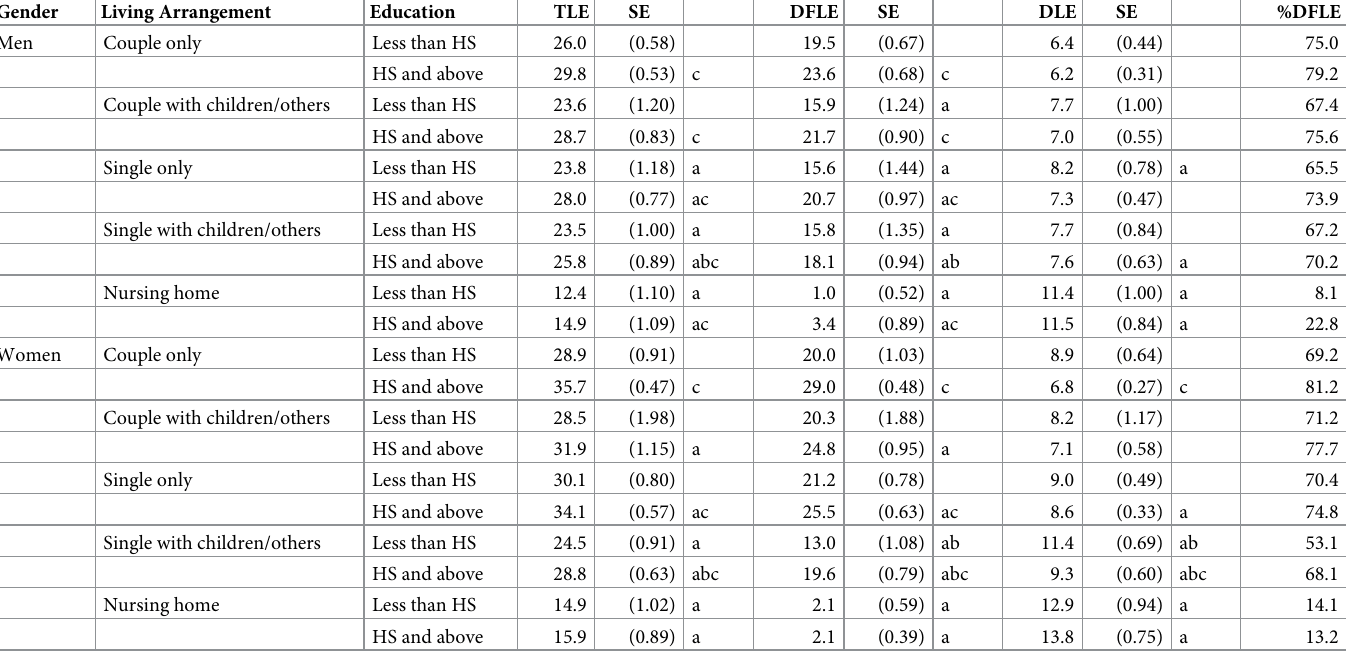
Table 12. Total, disability-free, and disabled life expectancy by gender, living arrangement, and education for non-Hispanic whites at age 50: Status-based estimates with initial health state being